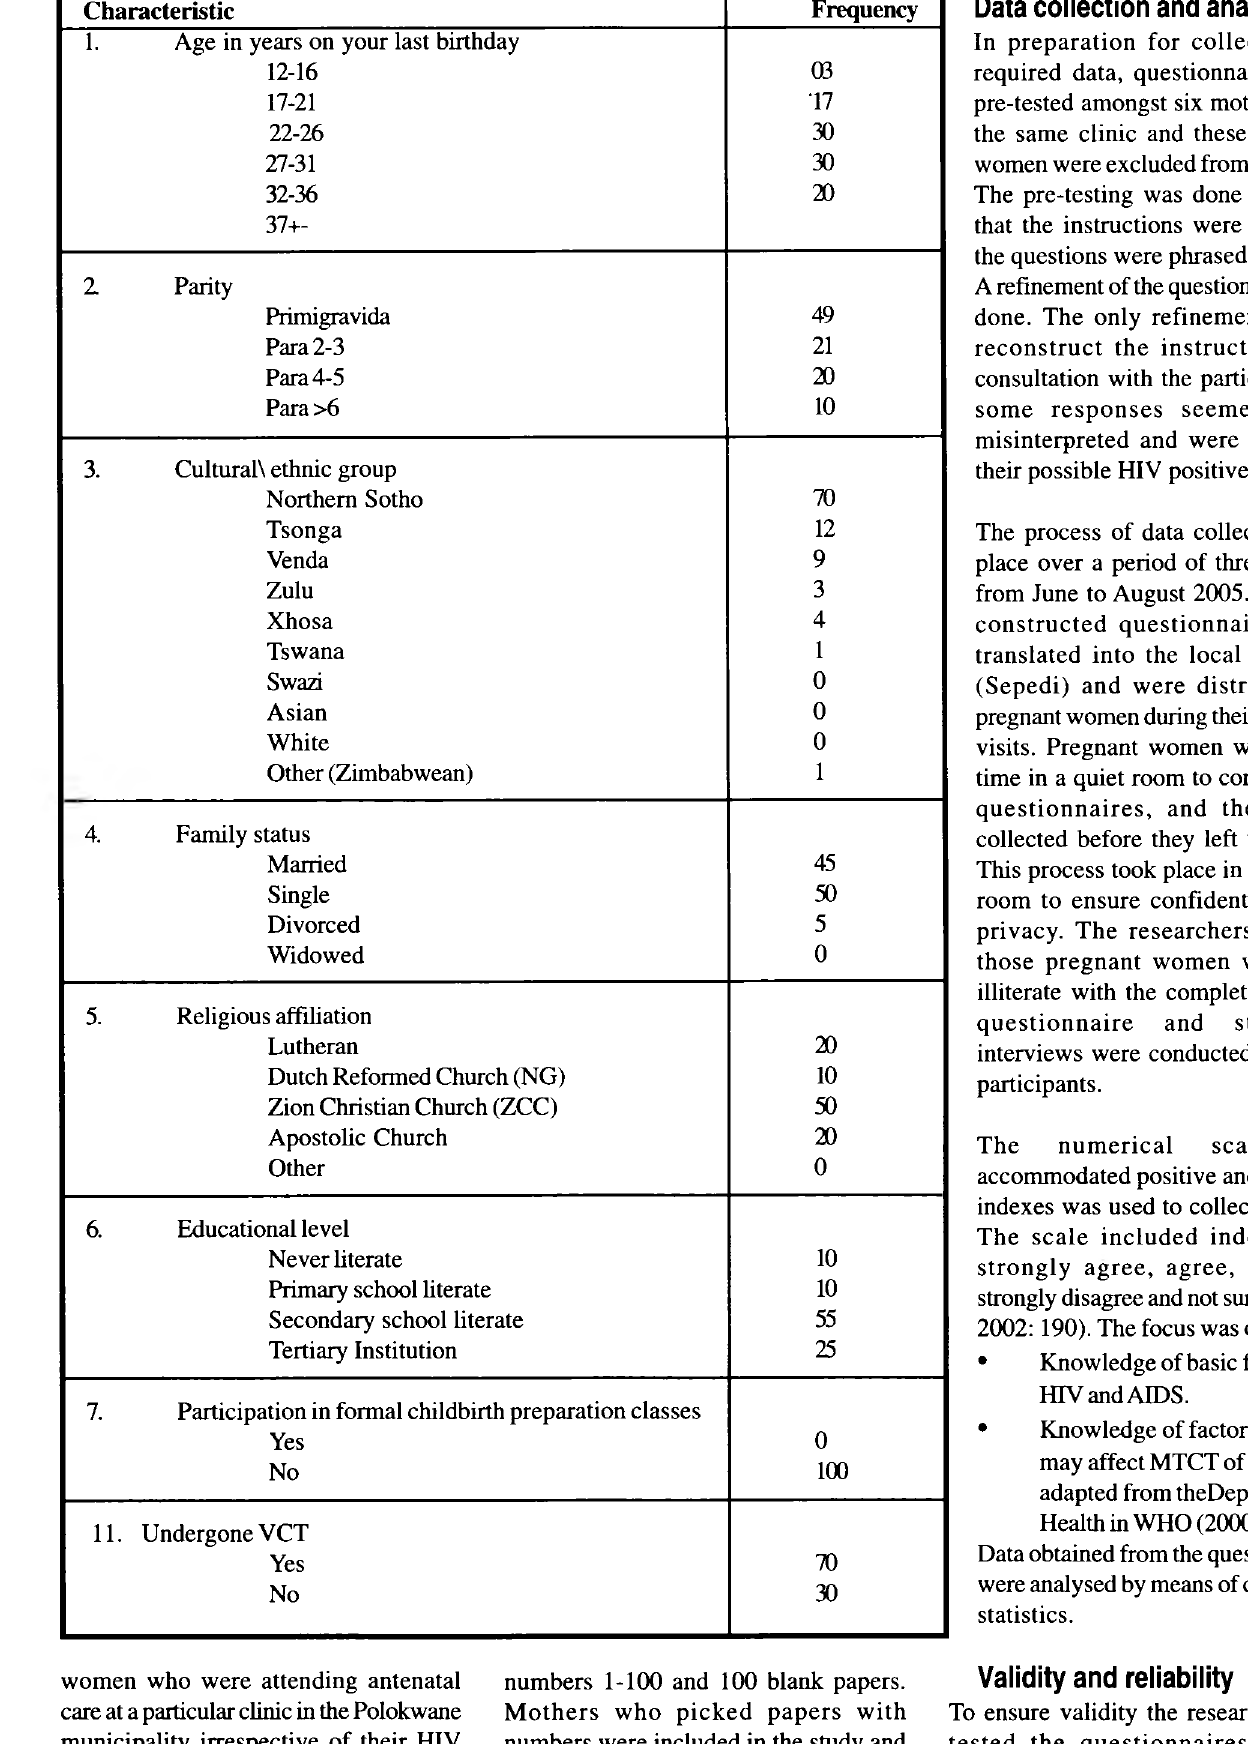
included in the study.